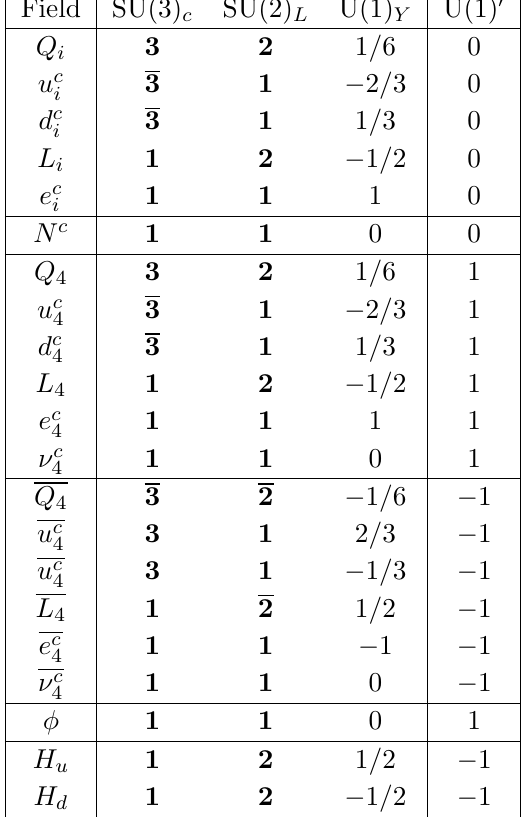
i = Q i ; L i and its CP